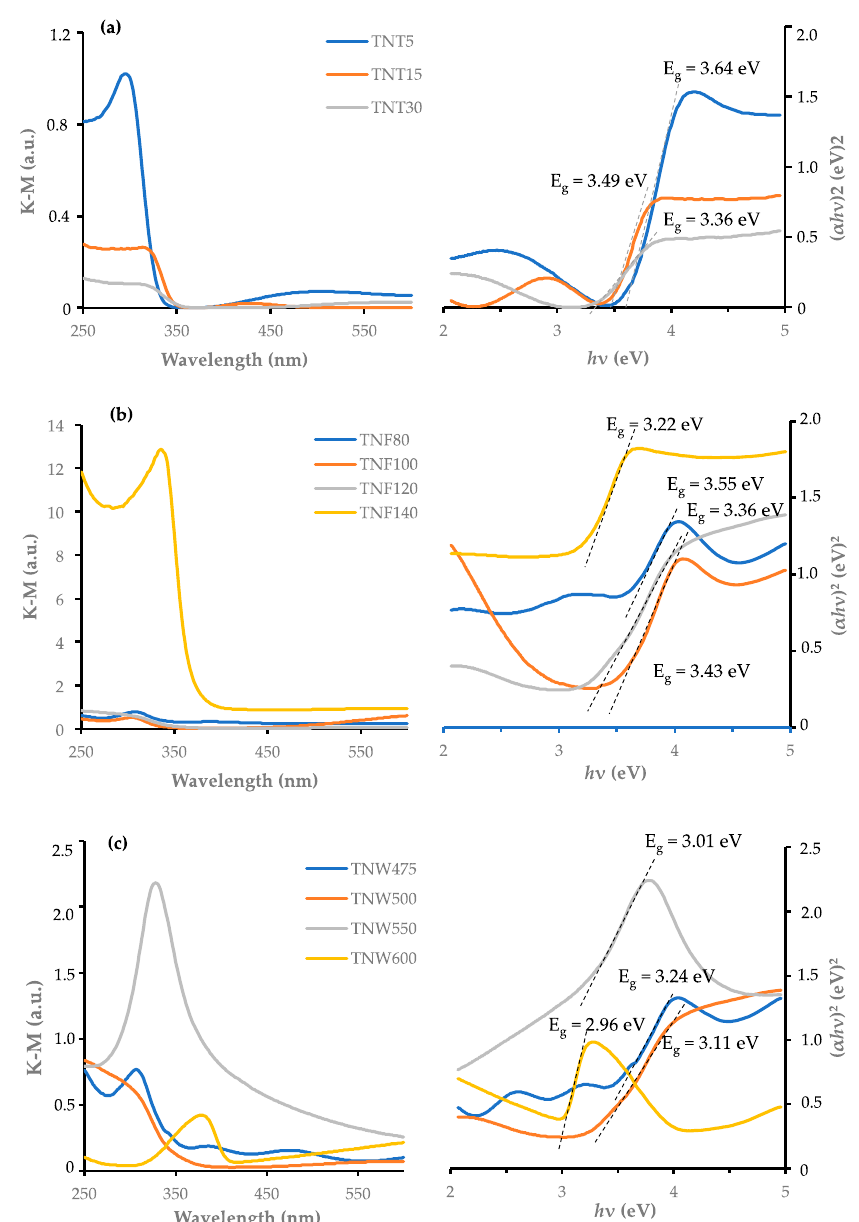
Figure 7. Diffuse reflectance UV-Vis spectra of TNT ( a ), TNF ( b ), and TNW ( c )—the left side; plots of ( α h ν ) 2 vs. h ν with the explanation the procedure of band gap value estimation—the right side.